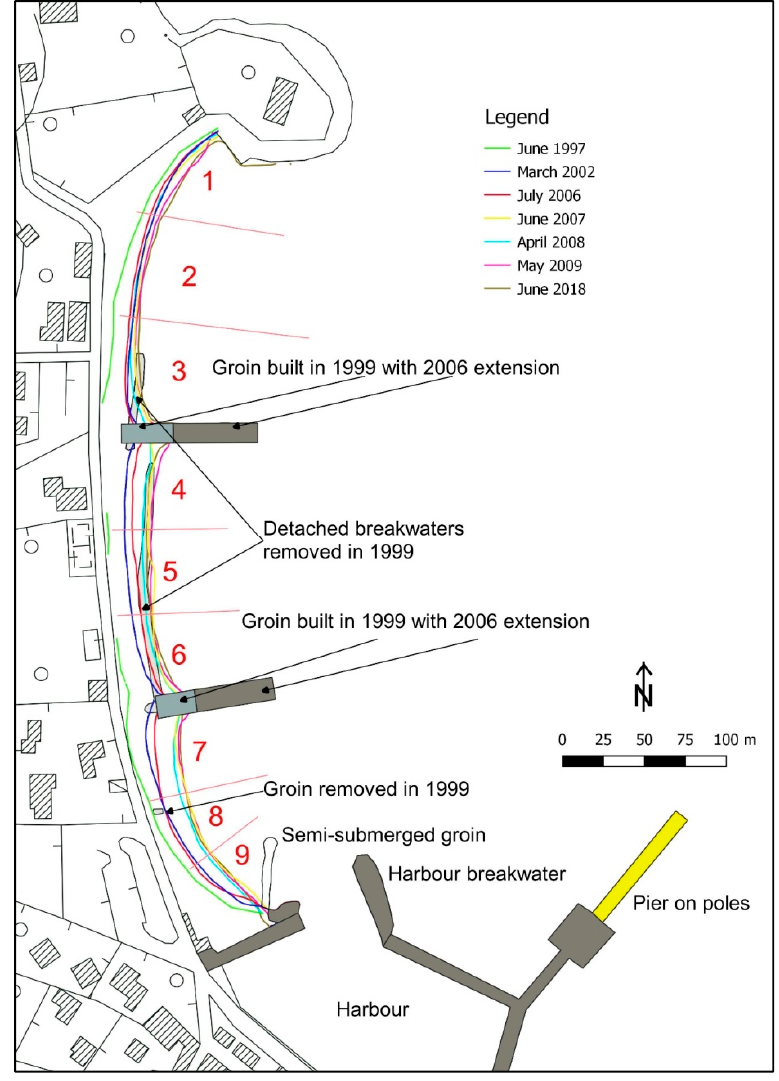
Figure 3. Shoreline (zero isobath) evolution at Cavo from 1997 (before the first nourishment) to 2018 (ten years after the end of the second nourishment). In red sectors